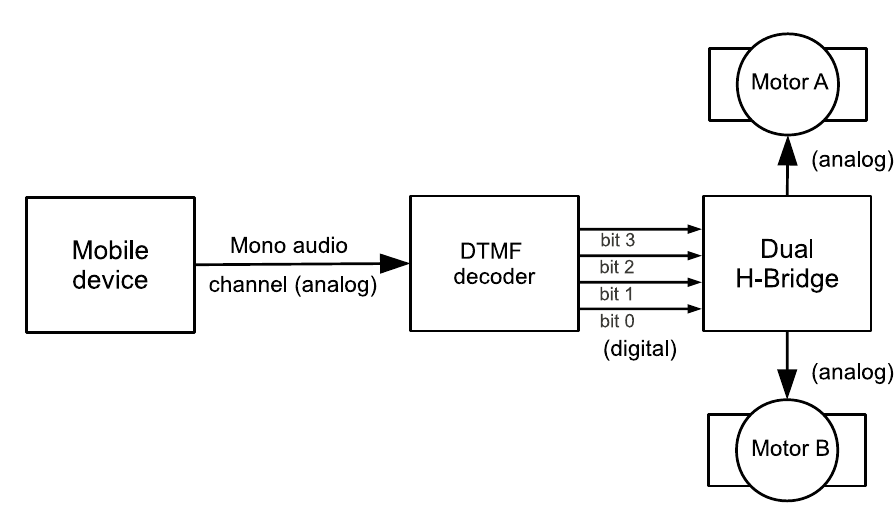
Figure 2. Dual motor control using one mono audio